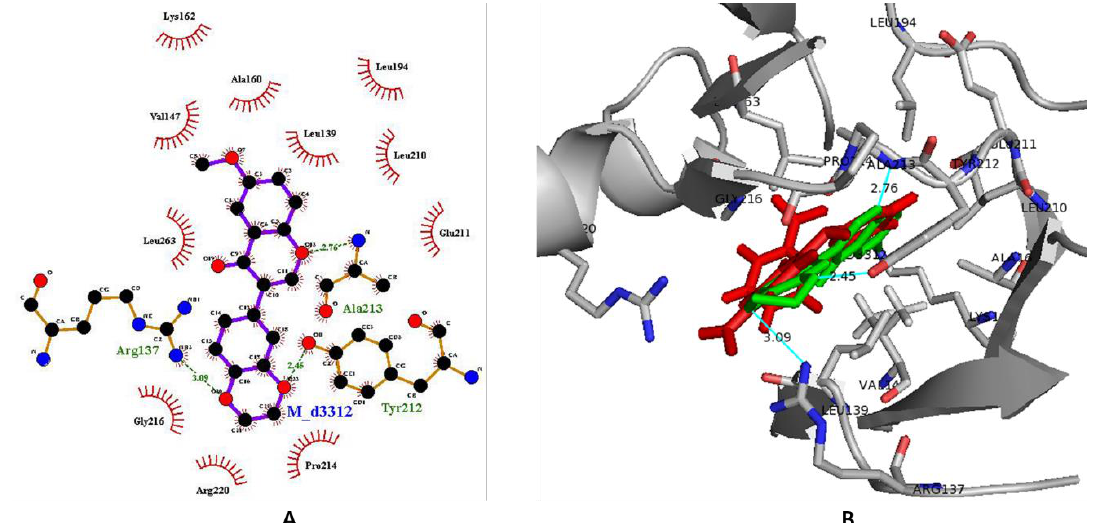
Figure 10. ( A ) The residues participating in the binding sites of the isoflavone 6 –AURKA complex analyzed by using the LigPlot program. ( B ) Three-dimensional image of the Aurora kinase A and isoflavone 6 complex, where isoflavone 6 is colored in green and the original ligand 0c3 contained in 3uod.pdb is colored in red.